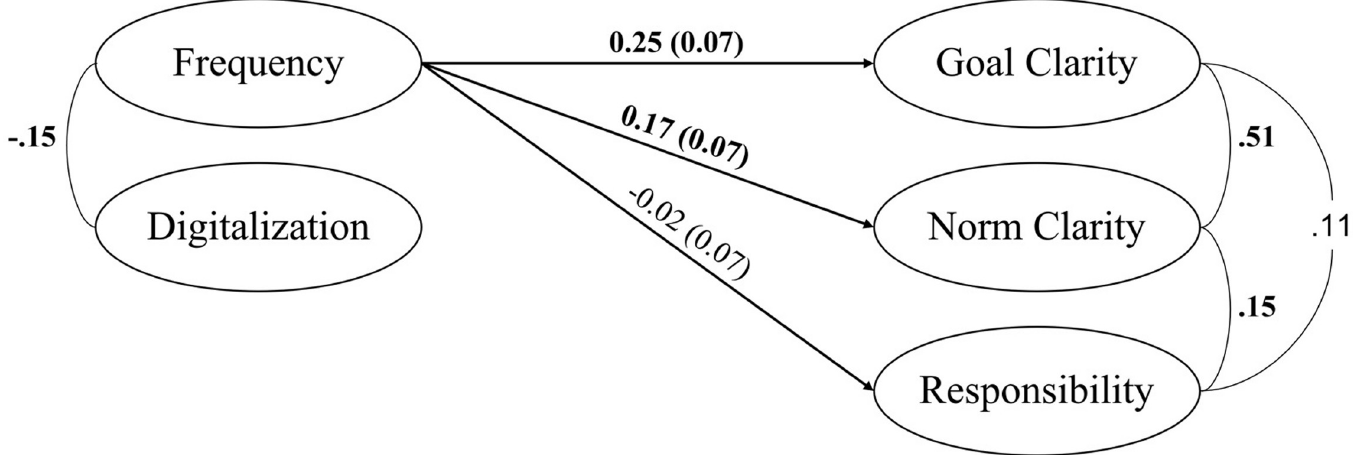
Fig 2. Structural model tested in Study 1 including H1–H4 ( N = 200). Estimates in bold are significant.